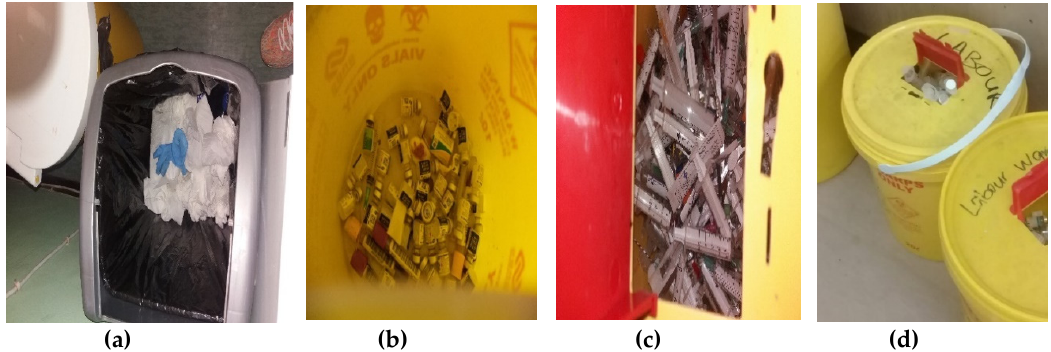
Figure 2. Photos taken by researcher during field work showing: healthcare risk waste (HCRW) used gloves mixed with general waste in a general waste bin ( a ); mixing of infectious waste (soiled cotton wool) with sharps (glass tube) and vials waste ( b ); mixing of general waste (paper package of syringe) with sharps (needles) ( c ) and filling of HCRW bin beyond the ¾ recommended level ( d ).